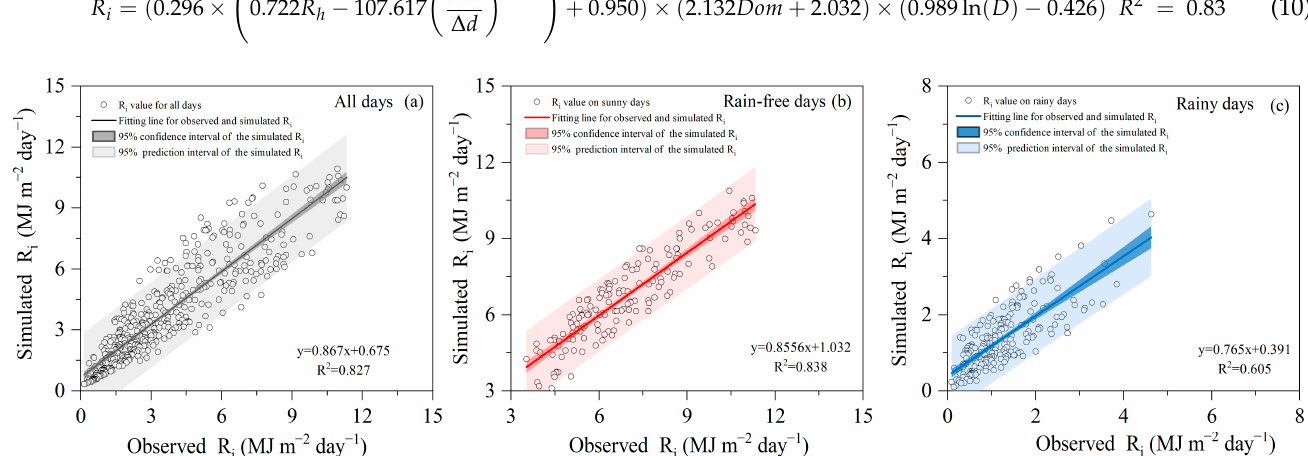
Figure 8. Comparison of the observed and simulated R i values based on Equations (10)–(12) under the different weather conditions. ( a ) Comparison of the observed and simulated R i values for all days. ( b ) Comparison of the observed and simulated R i values for rain free days. ( b ) Comparison of the observed and simulated R i values for all days. ( c ) Comparison of the observed and simulated R i values for rainy days.